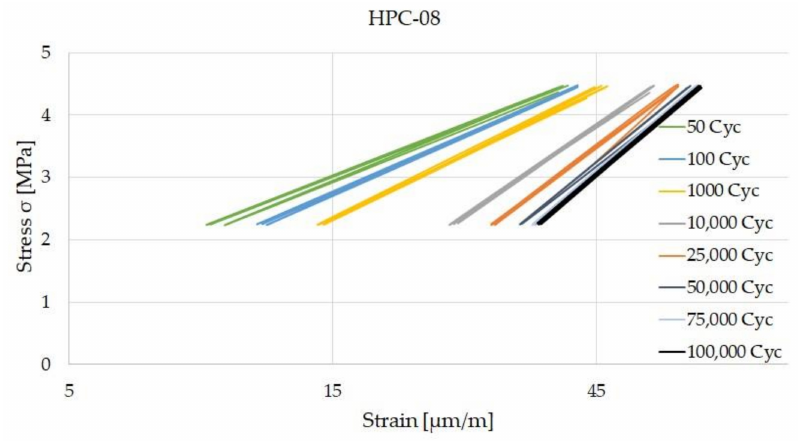
Figure 11. Stress-strain diagram of HPC-08 after 50 up to 100,000 Cycles.